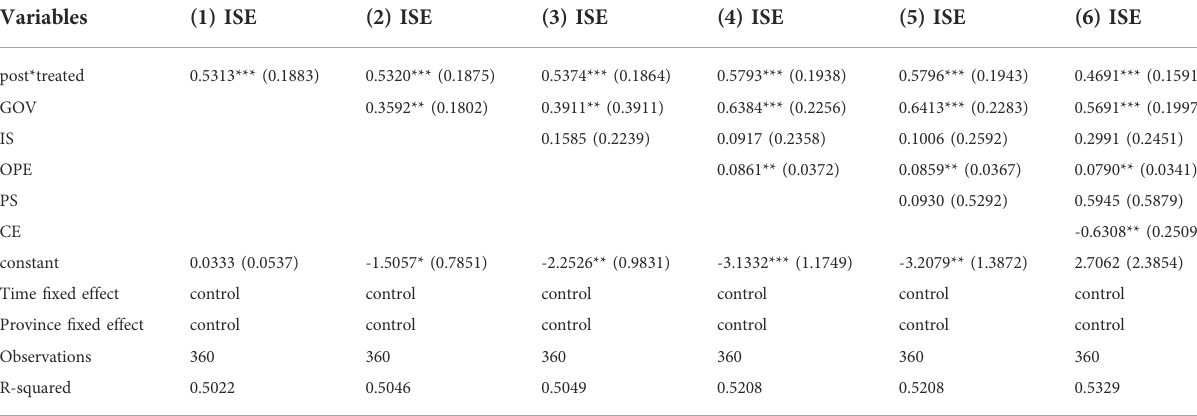
TABLE 1 Baseline regression results of carbon trading policy on ISE.